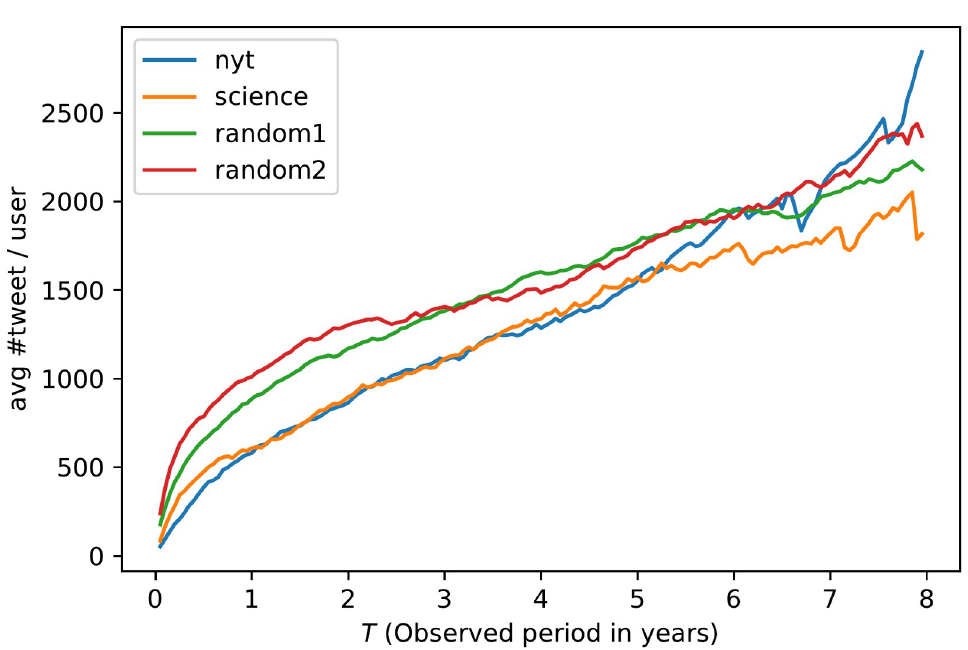
Fig 3. Tweets per user. Average number of tweets depending on the observation window. The Pearson linear correlation coefficient is equal to or greater than .98 for the four datasets.